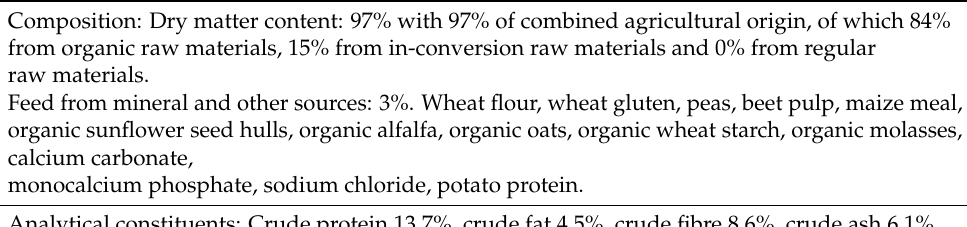
Table 1. Composition of the Reudink B.V. (Lochem, The Netherlands) organic complete feed for pregnant